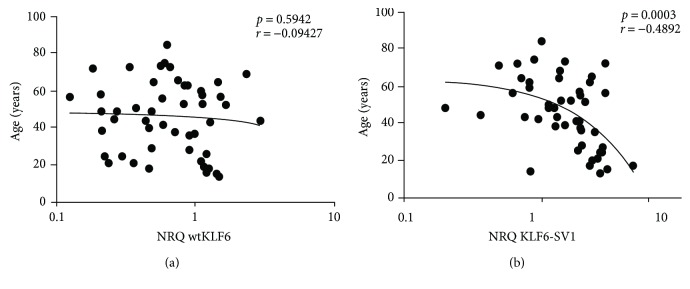
Correlation of wtKLF6 and KLF6-SV1 with age. Association between the expression levels of KLF6-SV1 (a) and wtKLF6 (b) with the age at diagnosis in NPC patients. All correlations were tested using the nonparametric Spearman method.